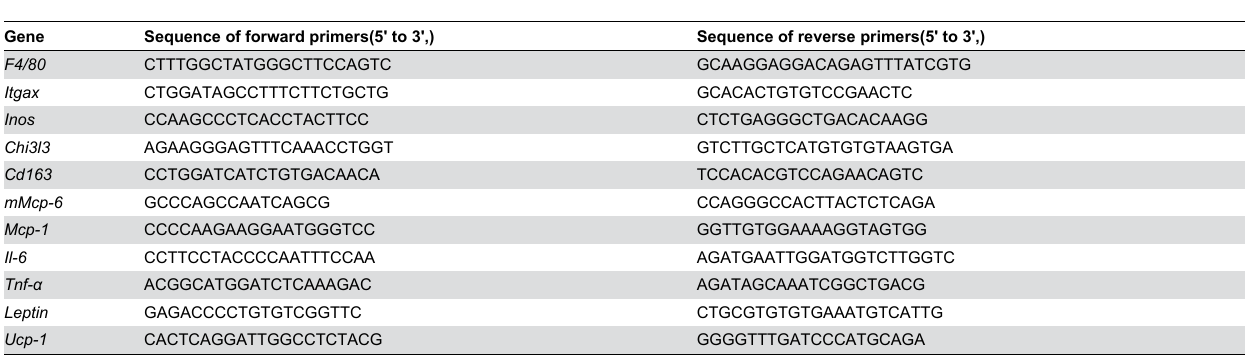
Table 2. Primers for quantitative real-time